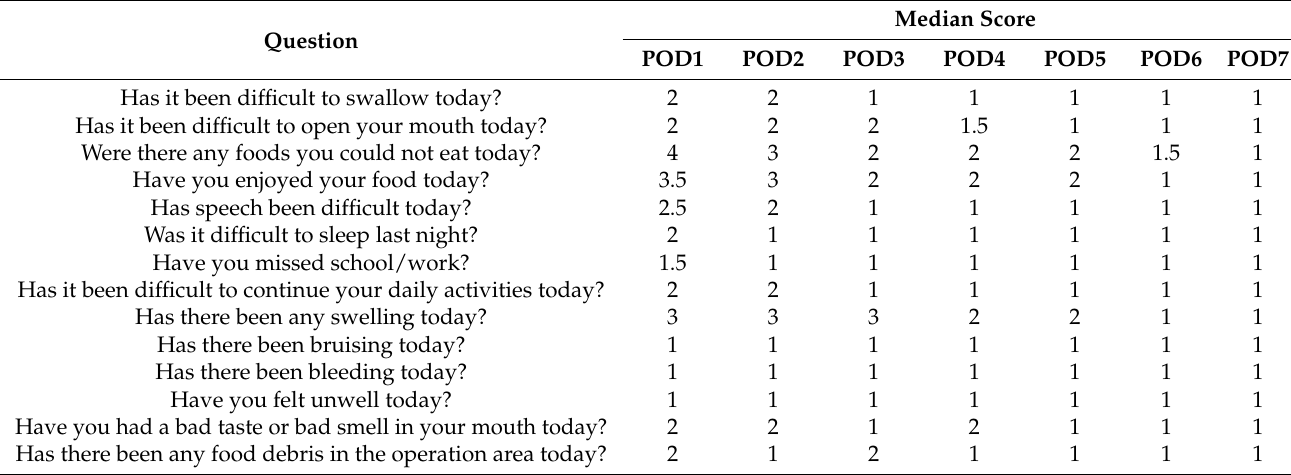
Table 1. Median questionnaire scores over time.